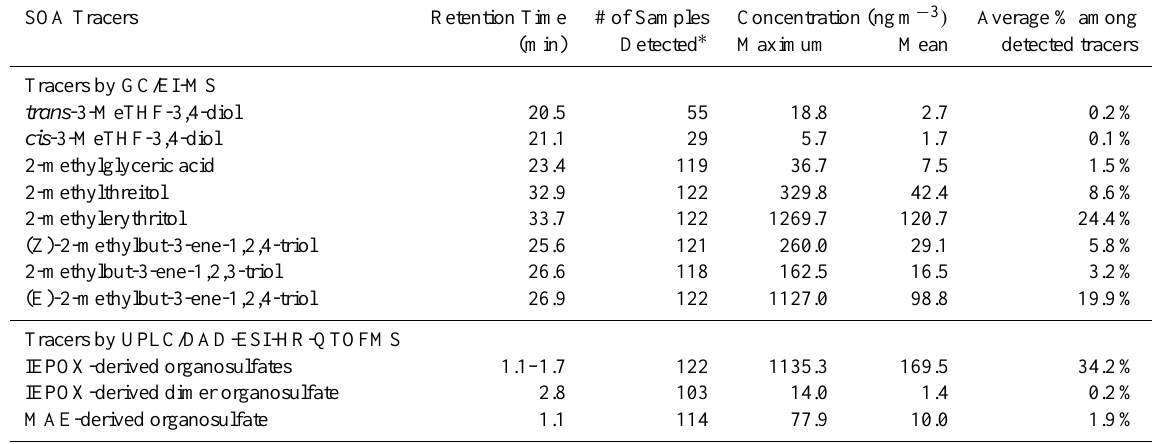
Table 1. Summary of isoprene-derived SOA tracers measured by GC/EI-MS and UPLC/DAD-ESI-HR-QTOFMS. SOA Tracers